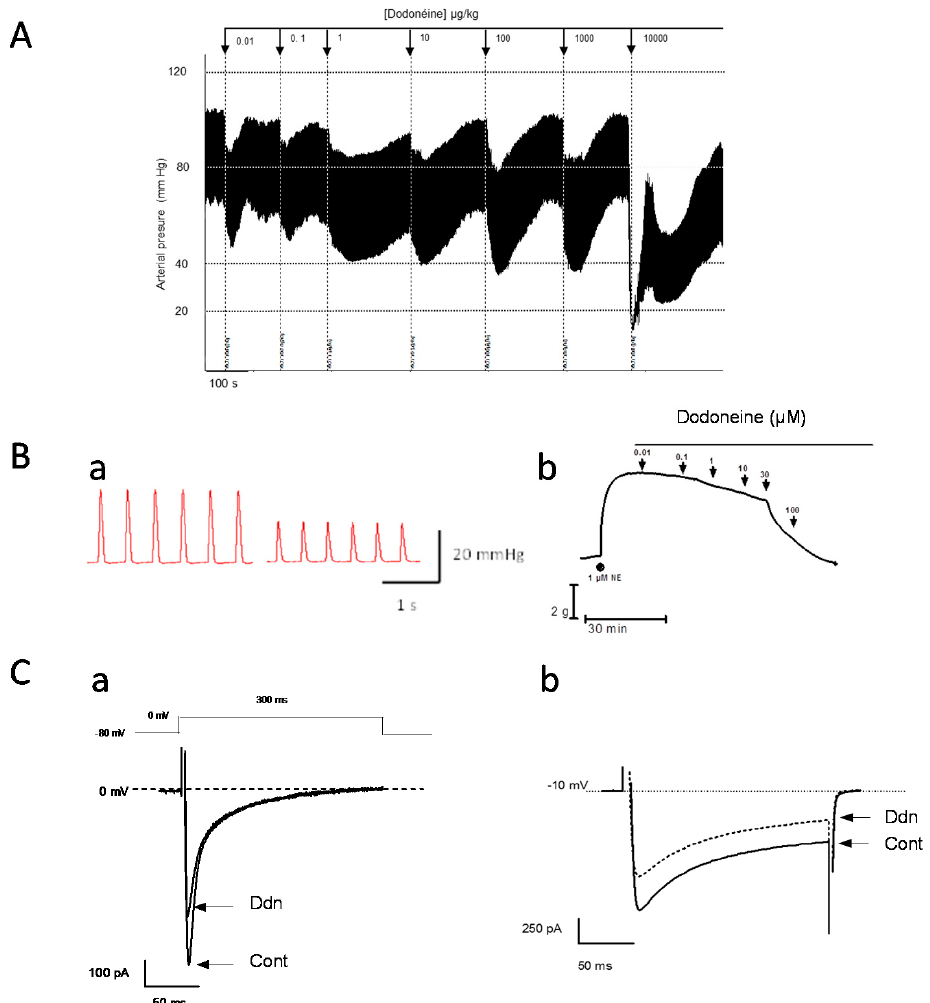
Figure 2. Physiological effects of dodoneine in vivo, ex vivo, and in vitro: on anesthetized rat carotidal blood pressure ( A ); on the left ventricular developed pressure (LVDP) of isolated perfused rat heart ( Ba ); on rat precontracted aortic rings ( Bb ); on the L-type calcium current recorded in cardiomyocytes ( Ca ); and on A7r5 smooth muscle cells line ( Cb ). Barium was used in substitution of calcium to record the current.